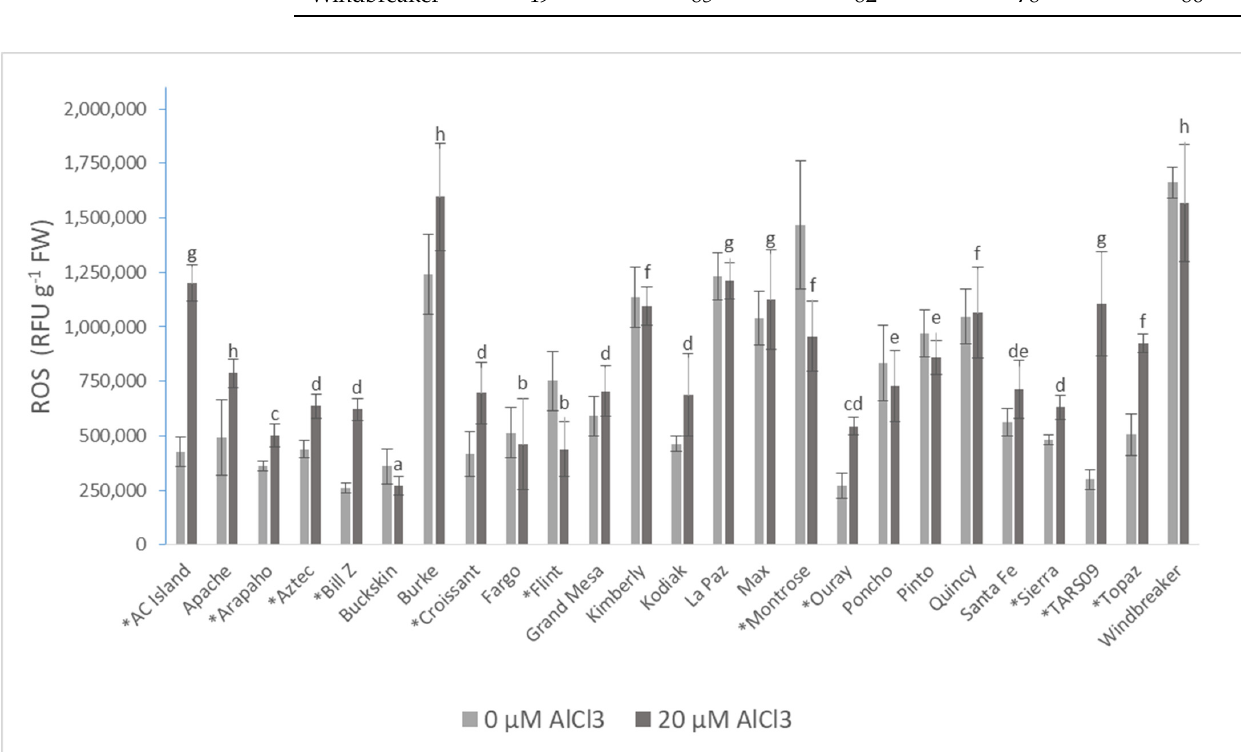
Figure 1. The total reactive oxygen species (ROS) of 25 common bean cultivars treated for 72 h with AlCl 3 . Values are the means of five biological and technical repetitions ± S.D. * Significant difference between treatments based on Shapiro–Wilk test ( p ≤ 0.05). Lowercase letters denote a significant difference among the AlCl 3 -treated cultivars. FW: fresh weight, RFU: relative fluorescence unit.